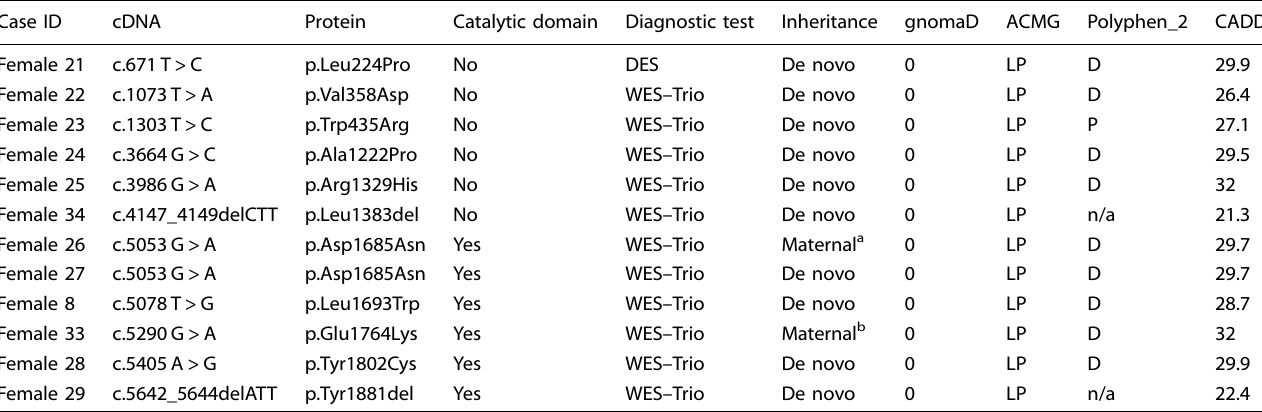
Table 1. Details of USP9X missense and single amino acid deletion variants associated with USP9X -female